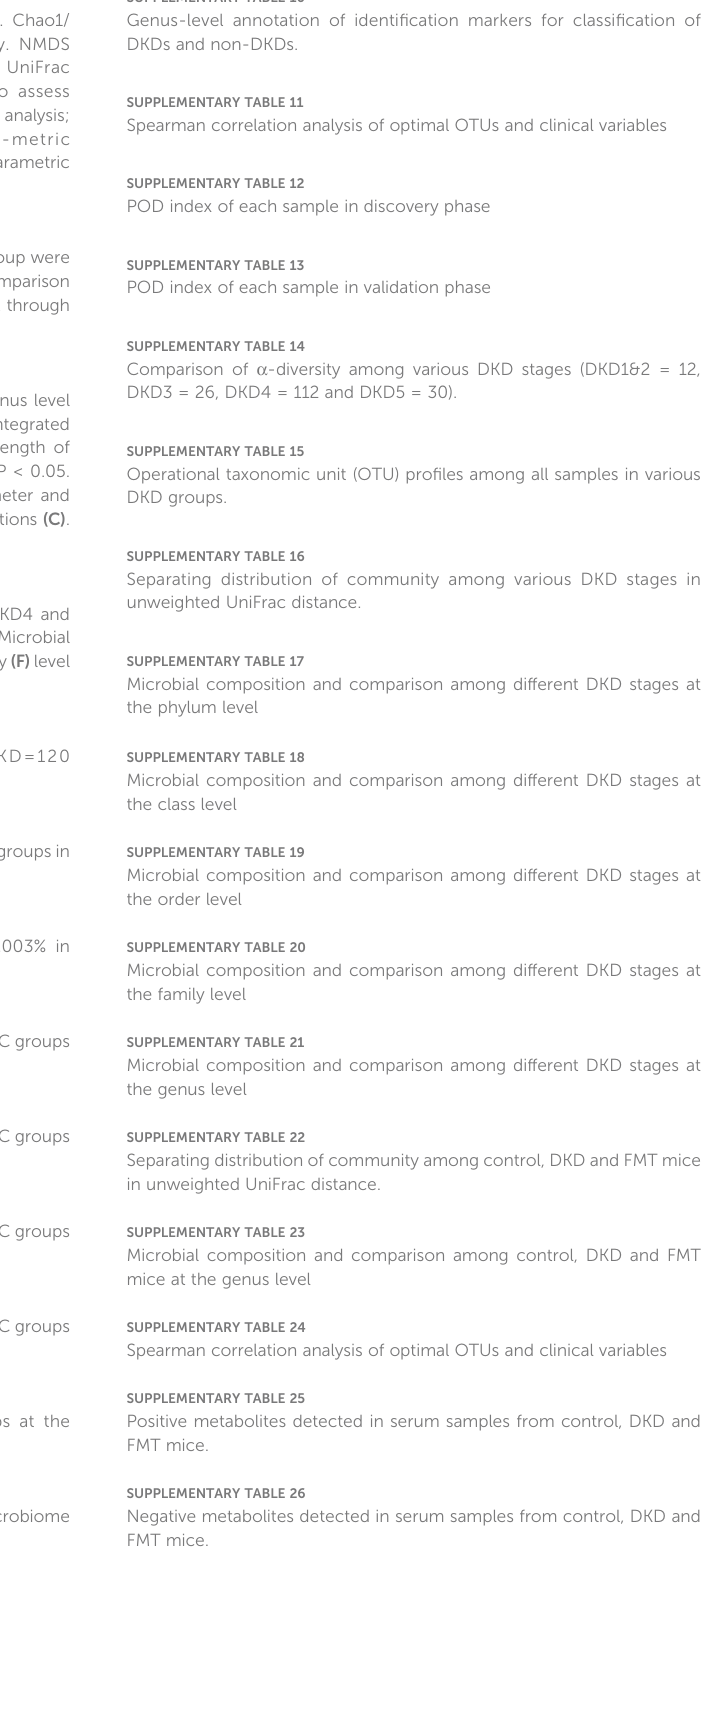
SUPPLEMENTARY FIGURE 2 Alpha and Beta diversity between DKD and non-DKD group. Chao1/